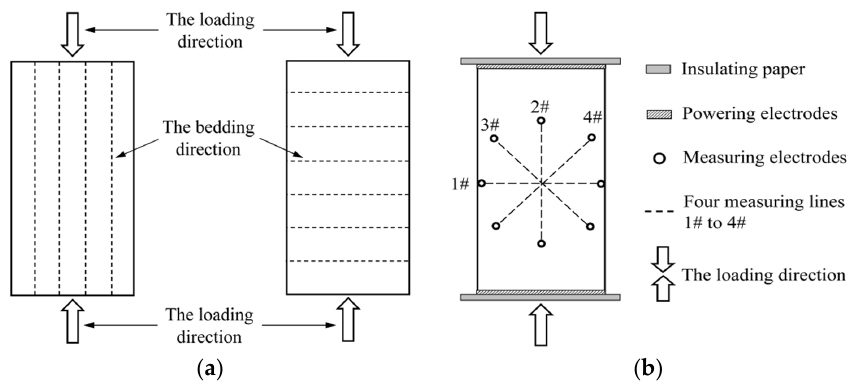
Figure 1. Schematic diagram of test device and method. ( a ) Relationship between the loading and bedding direction; ( b ) Measuring method.